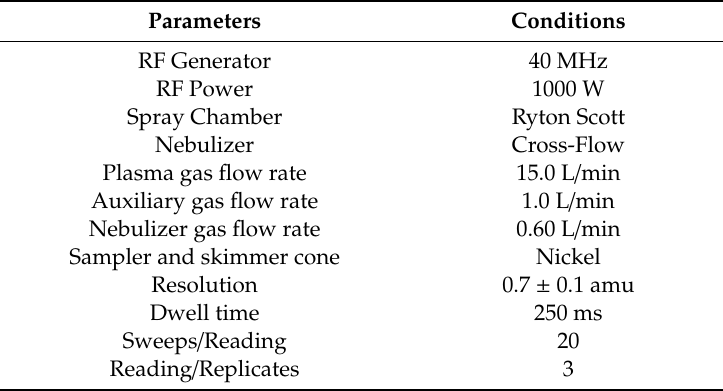
Table 2. Operating conditions for ICP-MS determination of Pb, Cd and As in digested henna. and walnut tree bark